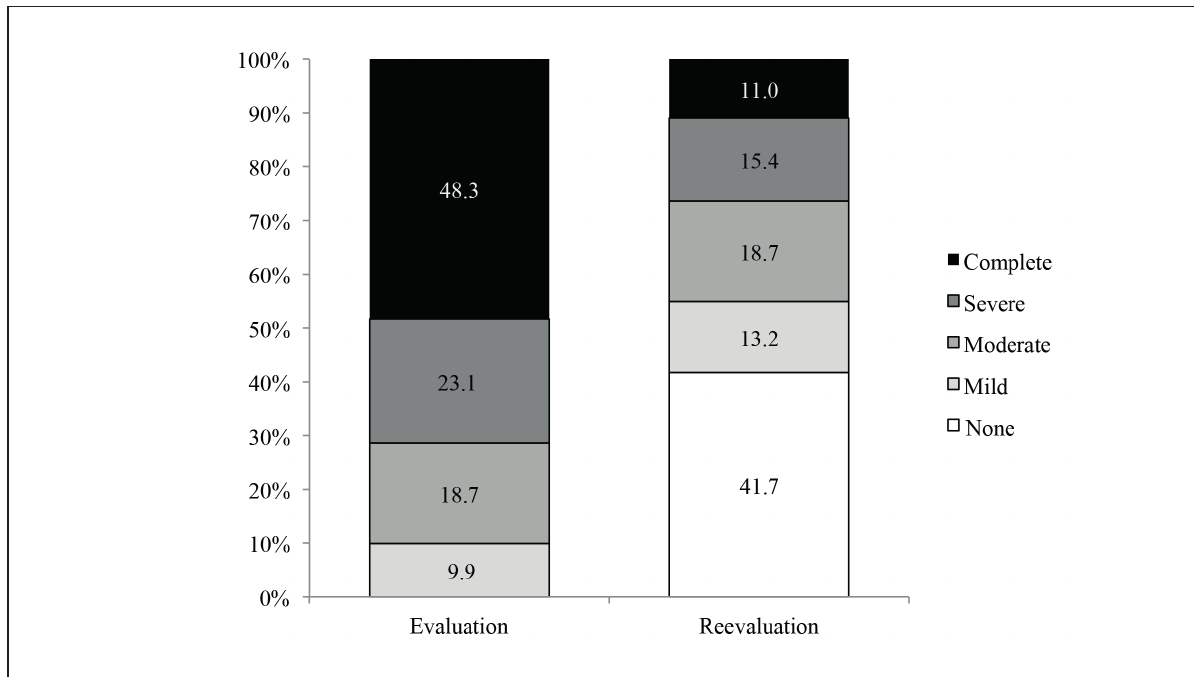
Figure 2 - Distribution of disability levels related to body structure in victims of traffic accidents at the time of evaluation and reevaluation (N = 91). Cuiabá/MT,